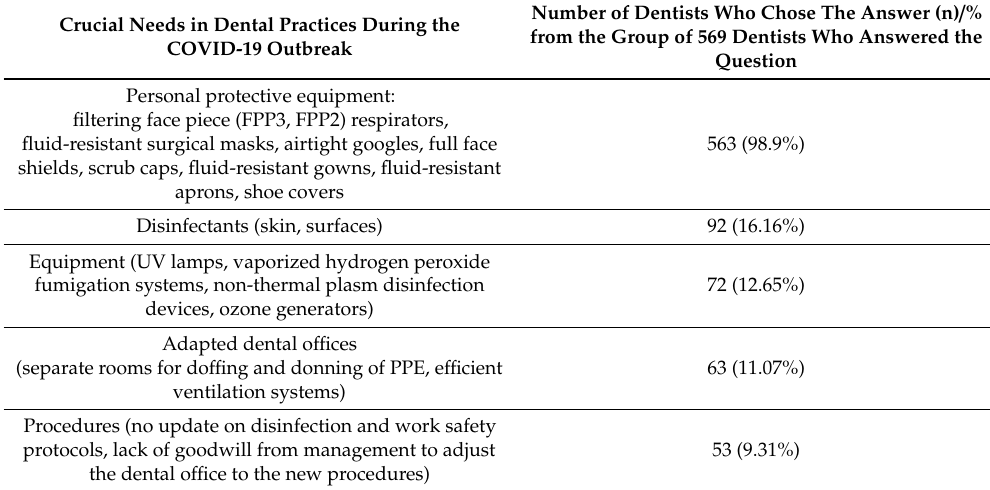
Table 3. Main demands in dental practices during the peak of the COVID-19 pandemic.